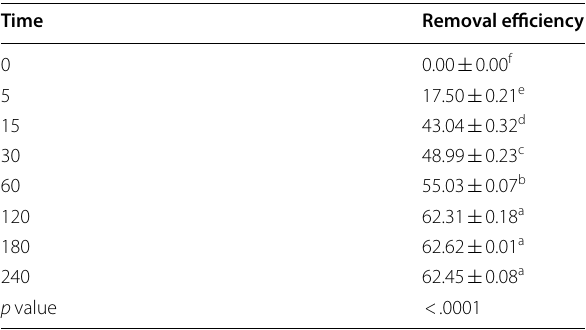
The letters indicate the level of significant and differences in the removal efficiencies of Cu2